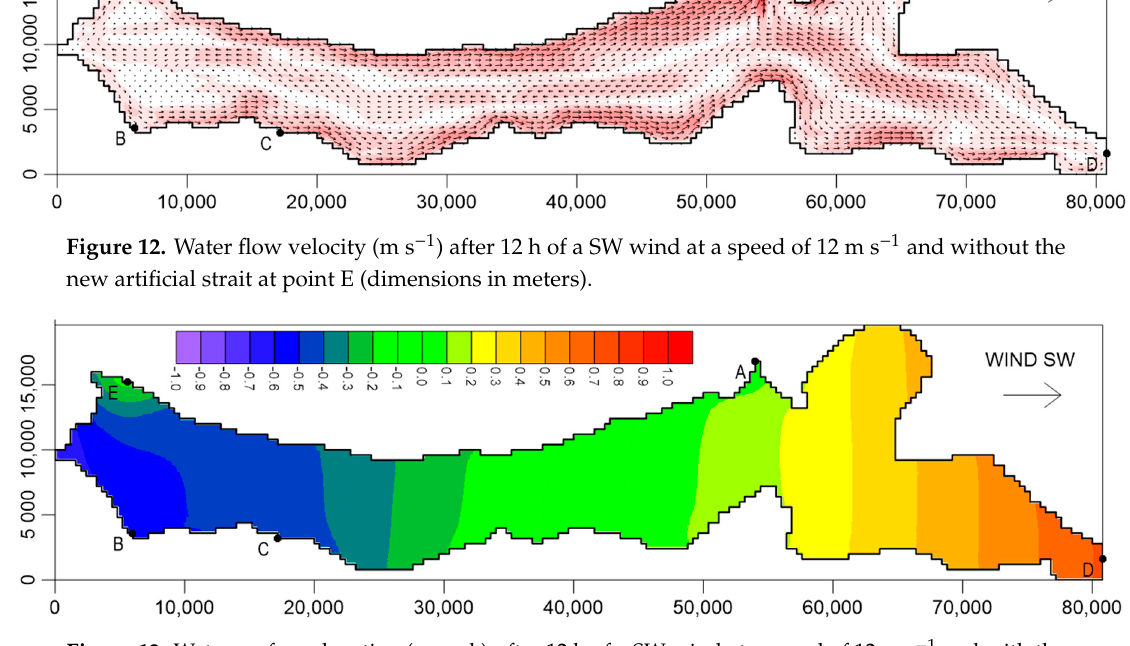
Figure 14. Water flow velocity (m s -1 ) after 12 hours of a SW wind at a speed of 12 m s -1 and with the new artificial strait at point E (dimensions in meters). In Figures 11 and 12, the calculated water level and flow velocity fields for a SW wind without the new strait are presented. Similar to the results obtained for the NE wind, the shape of the water free surface (Figure 11) is regular, but for the assumed meteorological conditions, the highest water level (above 0.4 m a.s.l.) is calculated at the Russian (NE) part of the lagoon (point D), while the lowest one (below –0.9 m a.s.l.) is observed at the Polish (SW) side of the lagoon (points B and E). The outflow of water into the sea through the Strait of Baltiysk (point A) was simulated for the given situation (Figure 8). Again, the area of water flow stagnation can be seen at the Polish end of the lagoon (points B, C, E). The results obtained for the same wind conditions, but with the consideration of both straits in the spit are shown in Figures 13 and 14. As in the previous case, after connecting the Vistula Lagoon to the Gulf of Gda ń sk with two openings to the sea, the hydrodynamic conditions of the lagoon are strongly modified. First, the water table increases, reaching 0.7 m a.s.l. in the Russian part of the lagoon. At the same time, the water level is raised to about –0.7 m a.s.l. in the vicinity of Elbl ą g (point B). Near the new strait (point E), the water table is higher due to the inflow of sea water through the open canal. The transformation of the velocity field is also significant. In contrast to the case of only one connection, one can observe the inflow and outflow of water through the new and existing straits, respectively. Such a situation allows the lagoon to be filled with fresh sea water and avoid water stagnation. The variation of the water level in time at the Polish side of the Vistula Lagoon in the area of Elbl ą g (point B) is presented in Figure 15. It can be seen that the new opening between the sea and the lagoon reduces the amplitude of the water stages at this location. The maximum water level observed for the NE wind is decreased by about 0.1 m for the assumed conditions, while the minimum water stage in this area is increased by about 0.2 m for the SW wind. The lowering of the water level during a storm surge is particularly important at this location due to the reduction of the flood risk in the polders on Ż u ł awy Elbl ą skie.